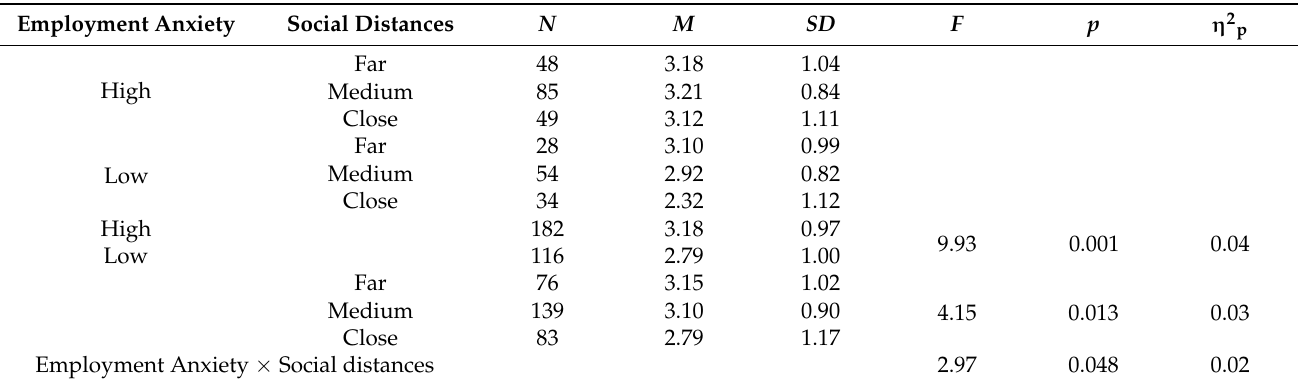
Table 1. Descriptive characteristics and ANOVA